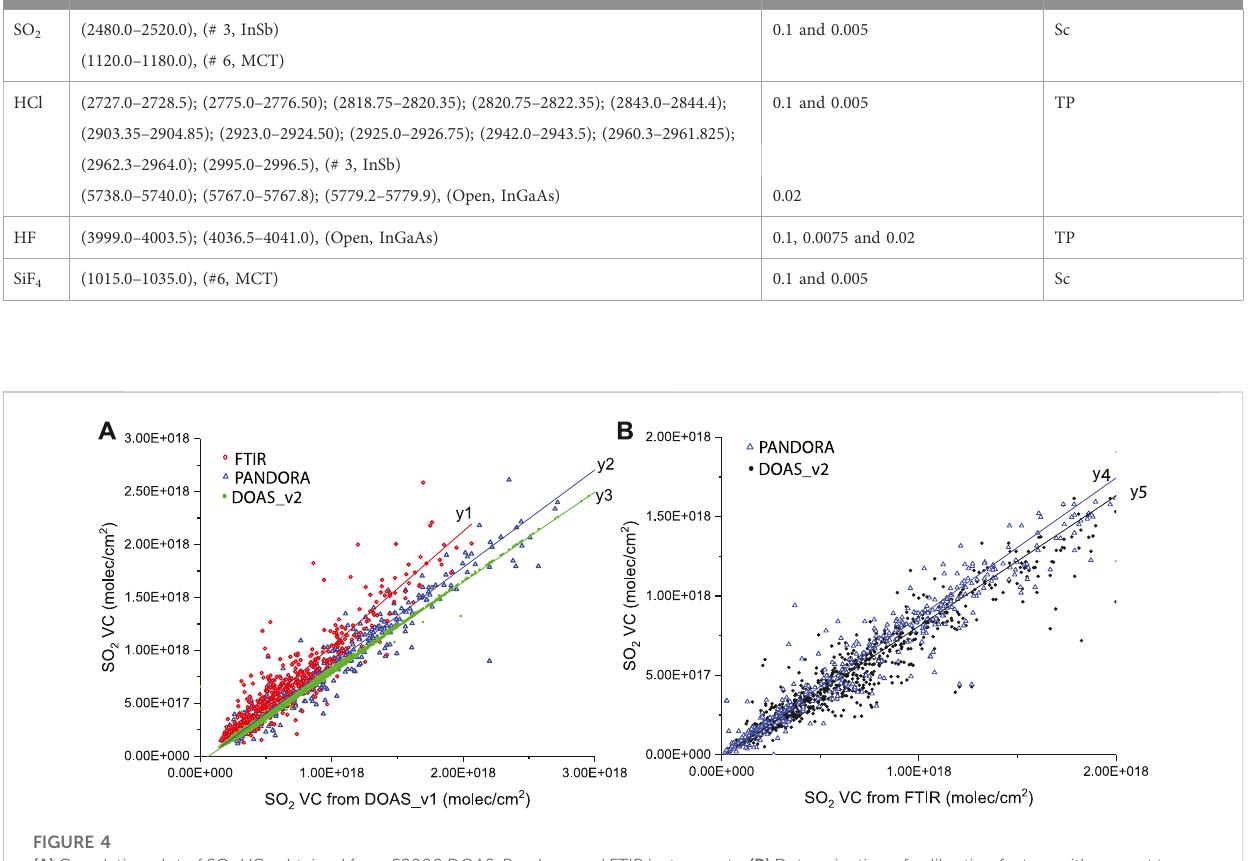
TABLE 2 Spectral ranges and retrieval strategies (detailed in Taquet et al., 2019) applied for the SO 2 , HCl, HF, and SiF 4 analysis from the FTIR data. TP refers to a pro fi le retrieval with a Tikhonov-Phillips regularization, and Sc to a scaling retrieval. Spectral windows (cm – 1 ), (NDACC fi lter number, detector)